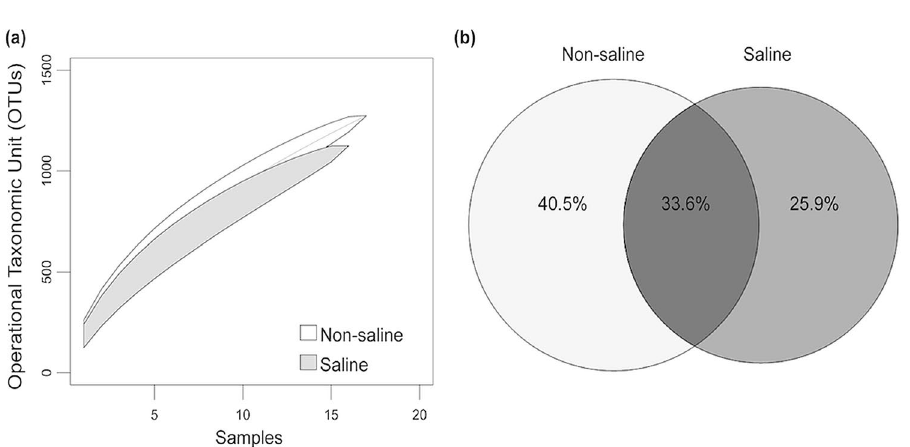
Figure 2. The species accumulation curves, unique and shared bacterial OTU analysis. ( a ) Operational taxonomic unit (OTU) accumulation curves at 97% similarity and ( b ) shared and unique OTUs of date palm root between irrigation sources (non-saline freshwater vs saline groundwater). The unique and shared OTUs are expressed as percentages of total OTUs